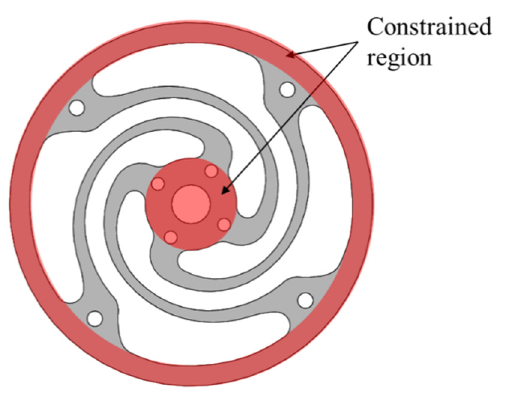
Figure 4. Constrained region in the flat spiral spring.